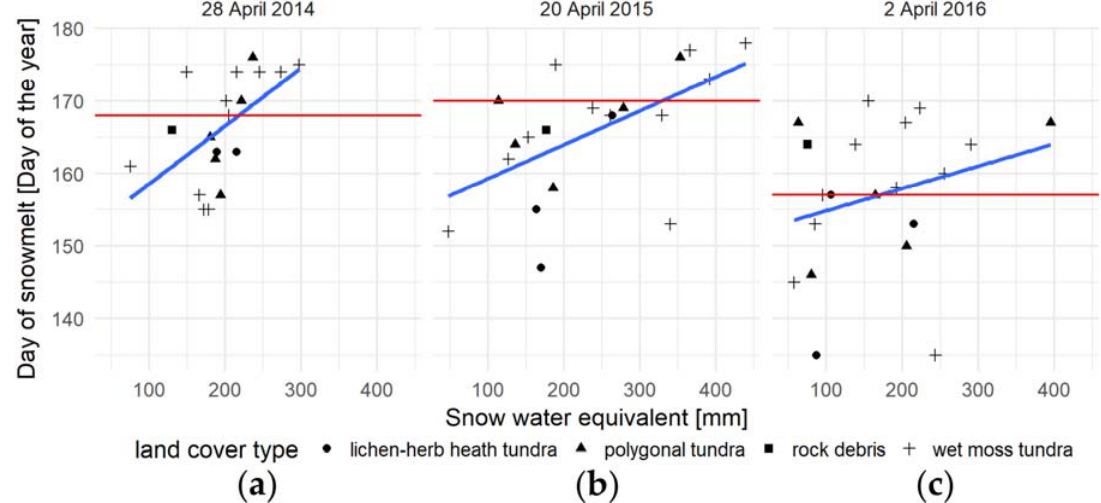
Figure 8. Relationship between date of snowmelt on manual soundings sites and SWE measured there during the maximum accumulation time that occurred: ( a ) 28 April in 2014, ( b ) 20 April in 2015 and ( c ) 2 April in 2016. Red horizontal line indicate the date of advanced stage occurrence (~33% SCE), blue line is a linear regression.